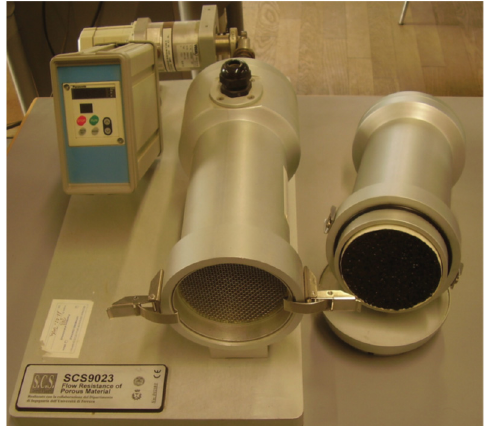
Figure 2. Device for measuring flow resistivity at the acoustic laboratory of the University of Cam- pania “Luigi Vanvitelli”, Department of Architecture and Industrial